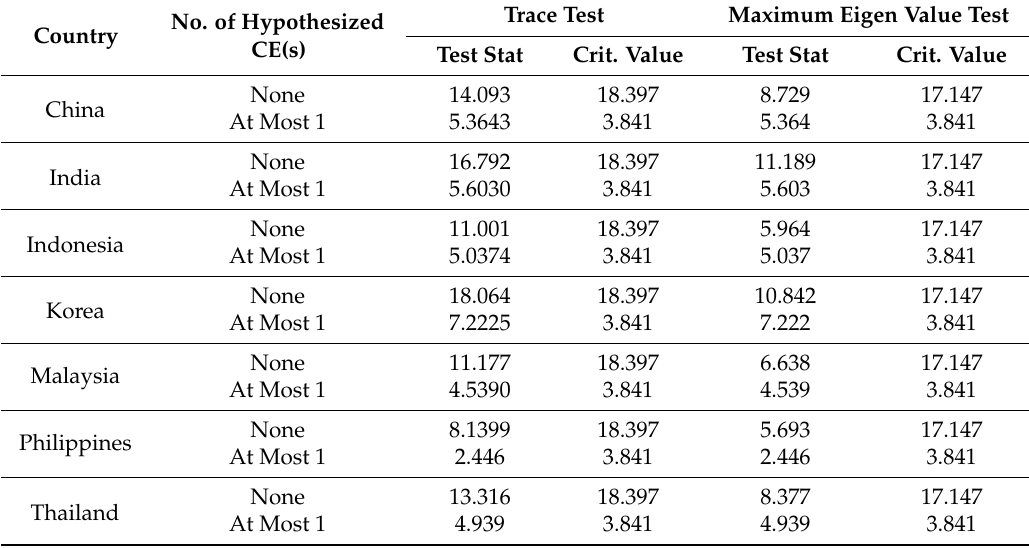
Table 4. Results of Co-integration